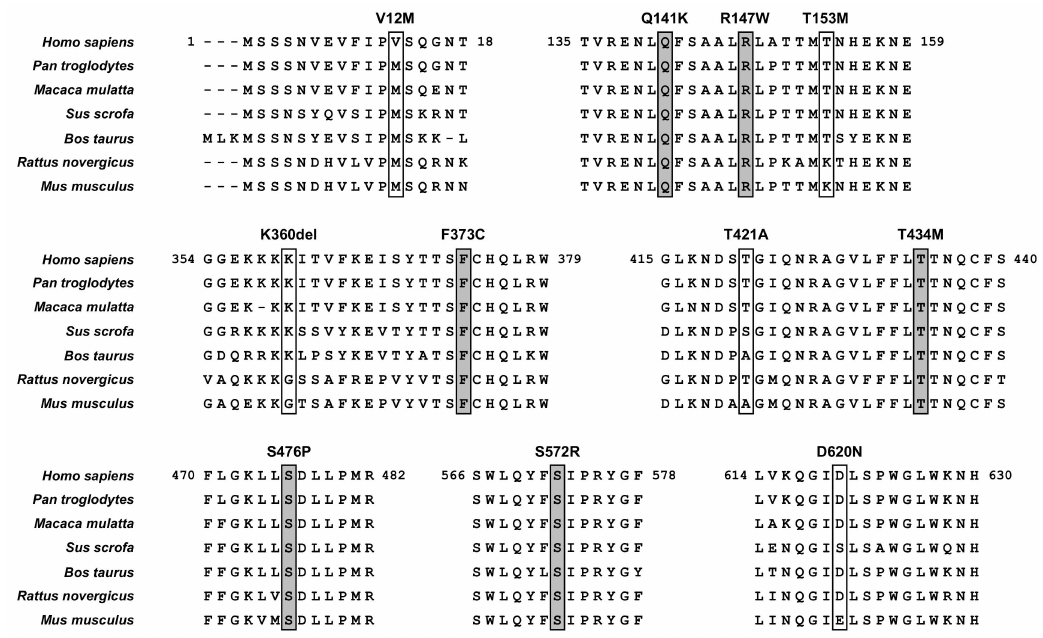
Figure 6. ABCG2 amino acids evolutionary conserved among seven mammalian species. The positions of non-synonymous substitutions conserved among seven species examined in the present study are grey labelled. Regarding Abcg2 protein in each species, NCBI Reference Sequence ID and amino acid sequence identity ( vs human ABCG2, NM_004827.3) are summarized as below: Pan troglodytes (Chimpanzee, GABE01009237.1), 99%; Macaca mulatta (Rhesus macaque, NM_001032919.1, 96%; Sus scrofa (Pig, NM_214010.1), 84%; Bos taurus (Bovine, NM_001037478.3), 84%; Rattus novergicus (Rat, NM_181381.2), 81%; Mus musculus (Mouse, NM_011920.3), 81%. Multiple sequence alignments